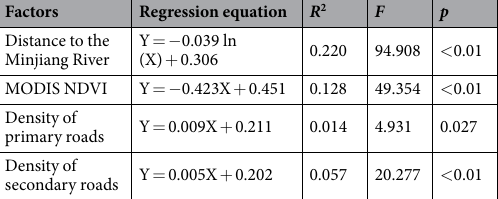
Table 1. Results of regression analysis using different factors as independent